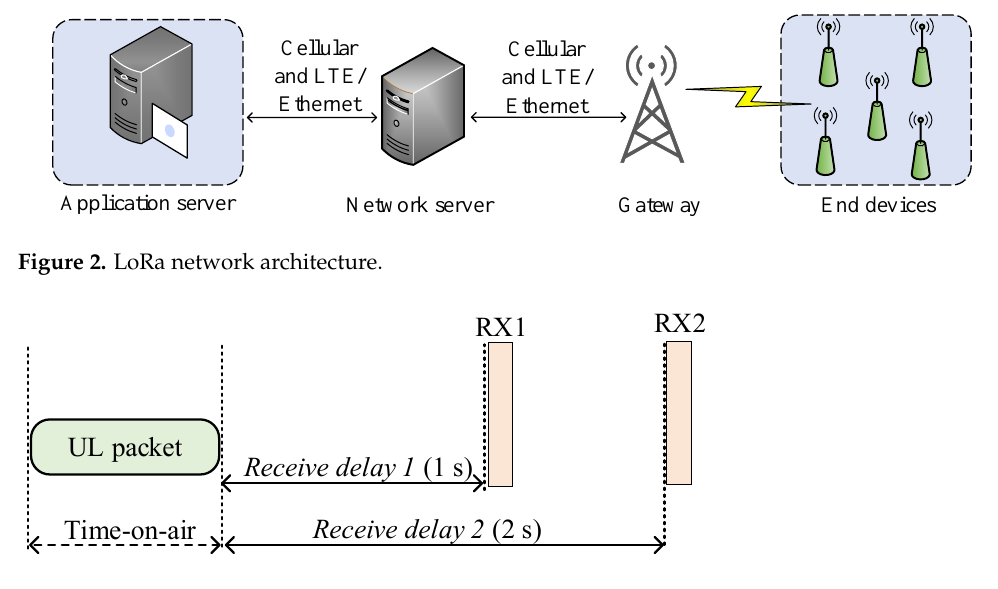
Figure 3. Receive windows operation in the confirmed mode of